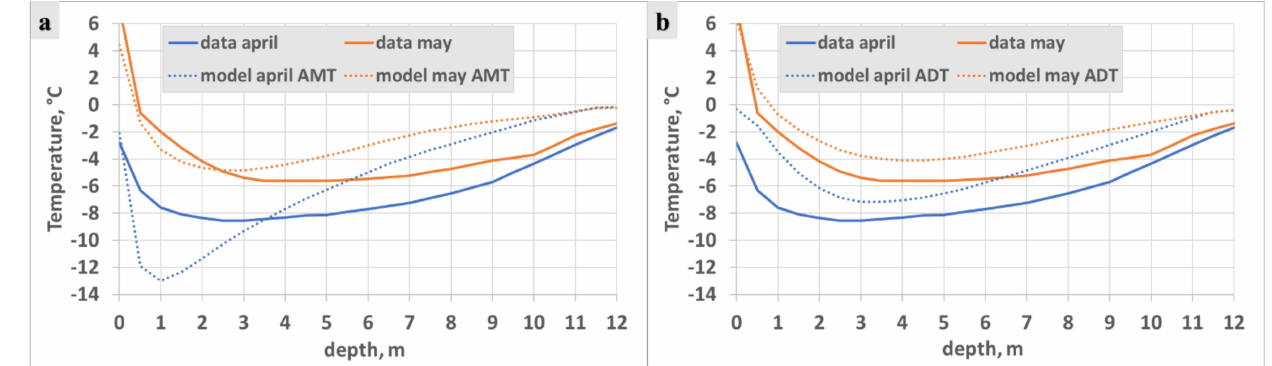
Figure 16. Temperature profiles calculated with average monthly temperatures—AMT ( a ), average daily temperature—ADT ( b ), in comparing with thermometry data for Building